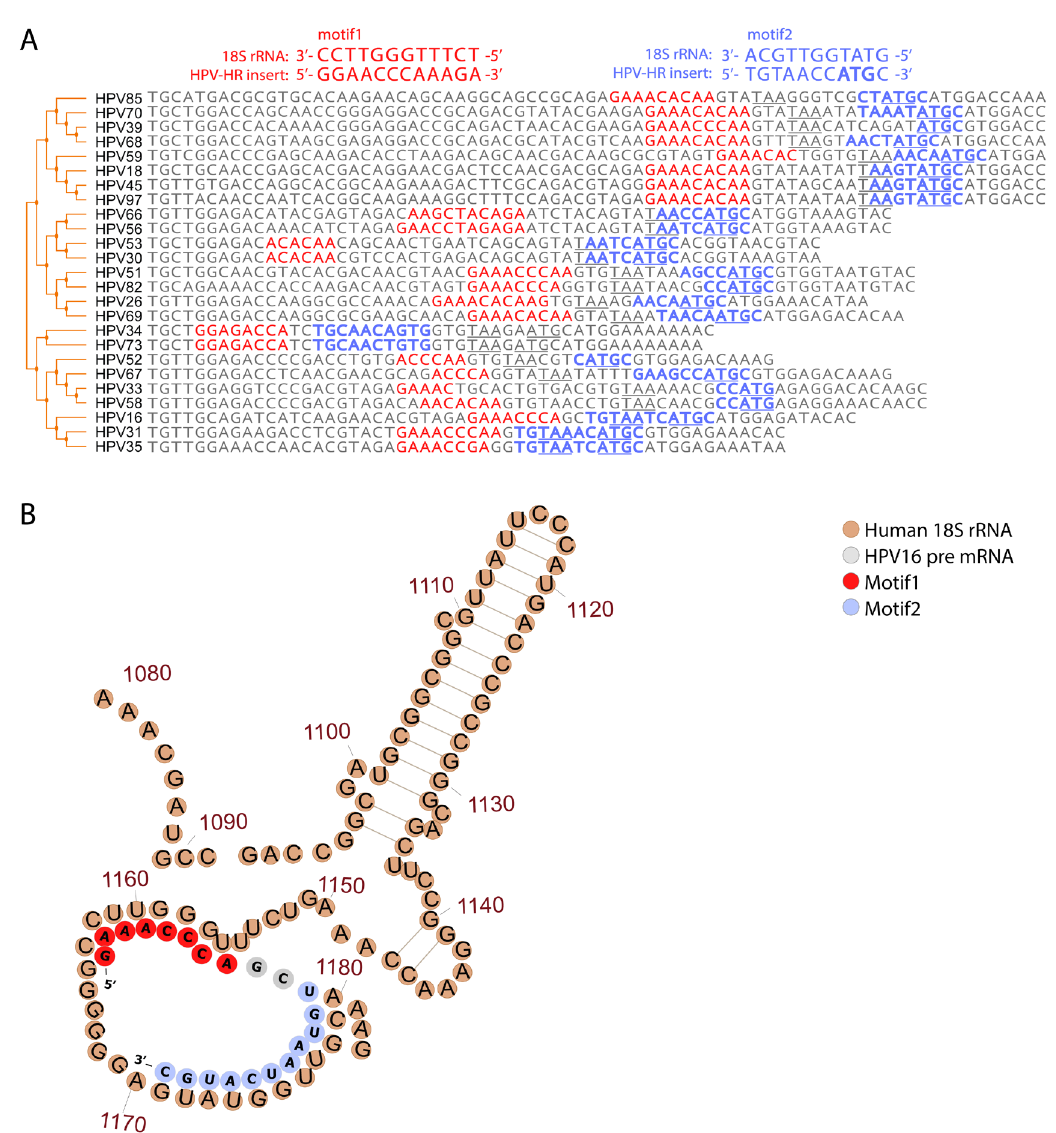
Figure 3. Sequences complementary to 18S rRNA sequence in the HR-HPV-specific insert. ( A ) Comparison of 18S rRNA complementary sequences for different HR-HPV strains. The distal and proximal to the E7 start motifs (motifs 1 and 2) to the E7 start codon are shown in red and blue, respectively. The E6 stop codons (TAA) and E7 start codons are marked in bold. ( B ) An illustration of the potential interactions between folded HPV16 pre-mRNA (grey, red and blue) and the human 18S rRNA (brown). The two motifs are marked on the HPV-structure in red (motif 1) and blue (motif